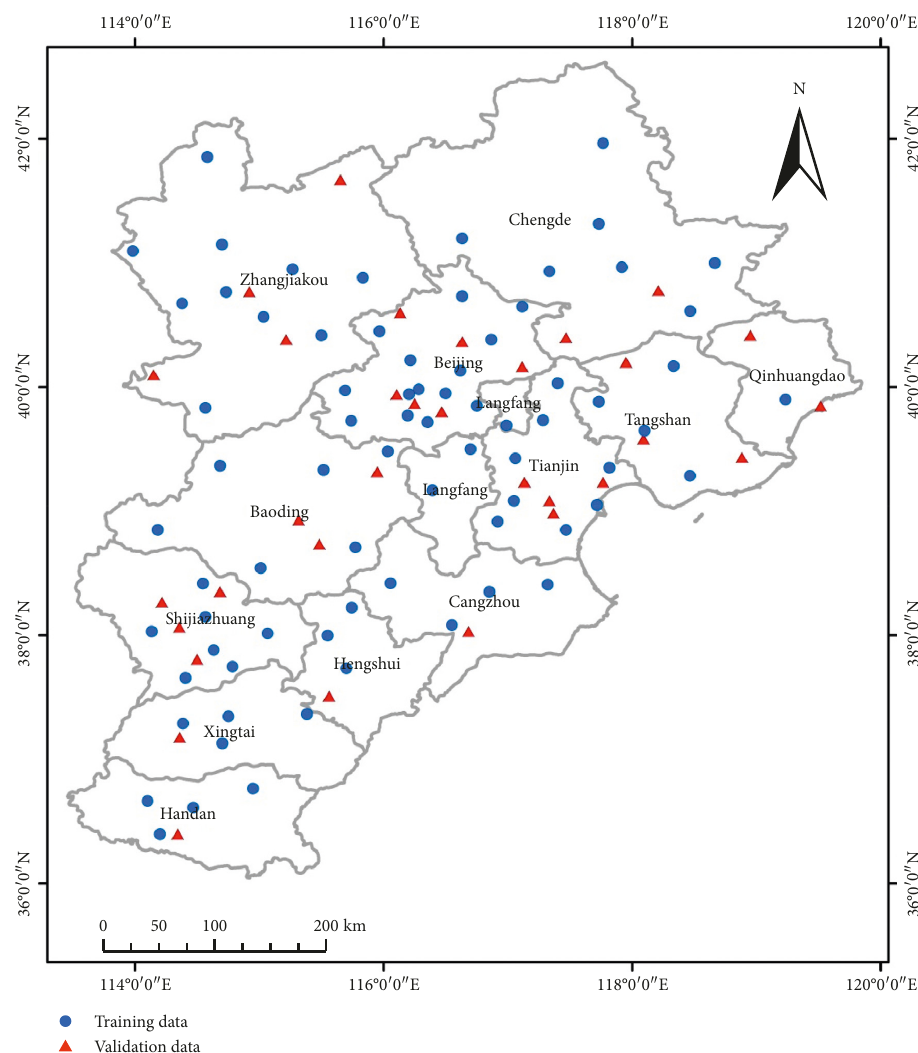
Figure 3: Distribution of training and validation data sources in the Beijing-Tianjin-Hebei region,